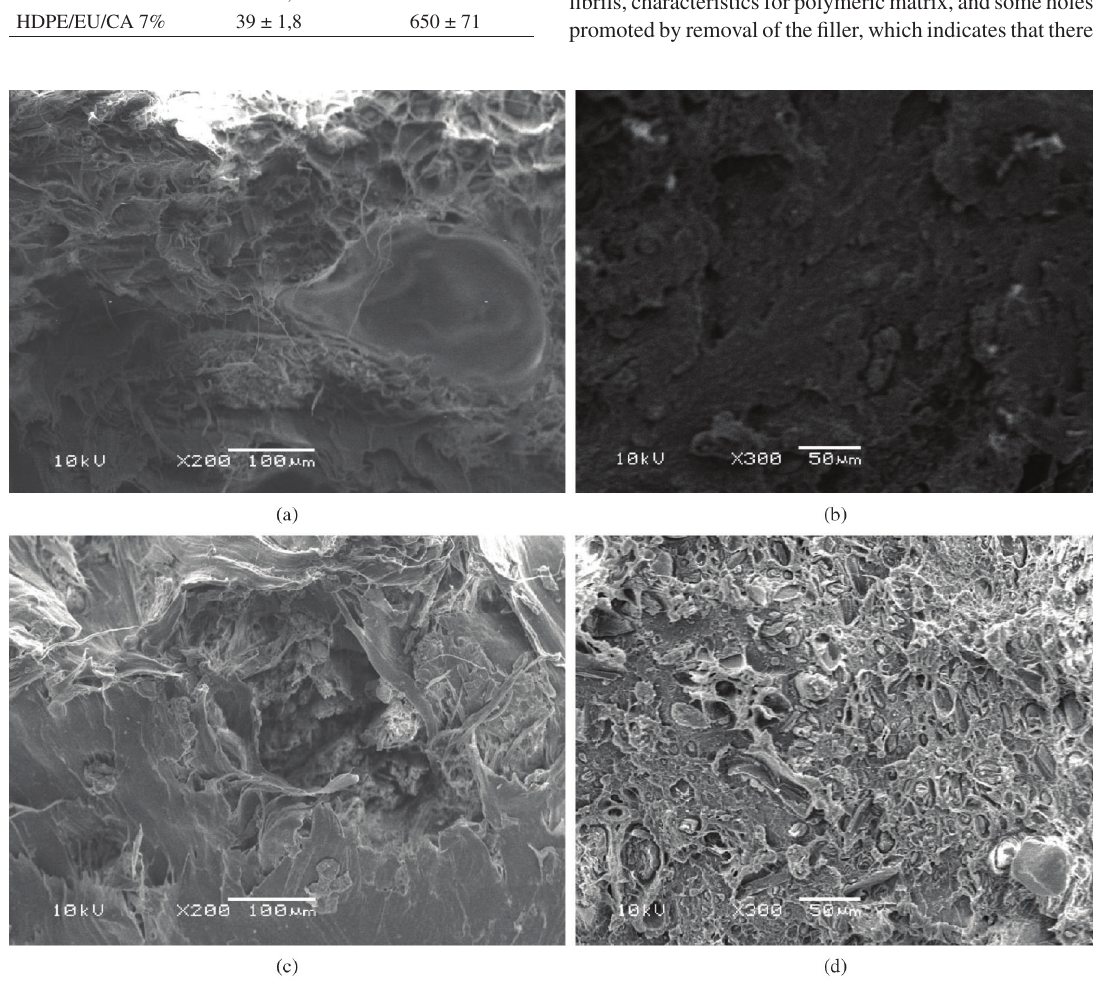
Figure 4. SEM micrographs of fracture surfaces of HDPE/EU/CA 1% (a), HDPE/EU/CA 3% (b), HDPE/EU/CA 5% (c) and HDPE/EU/ CA 7% (d) composites.